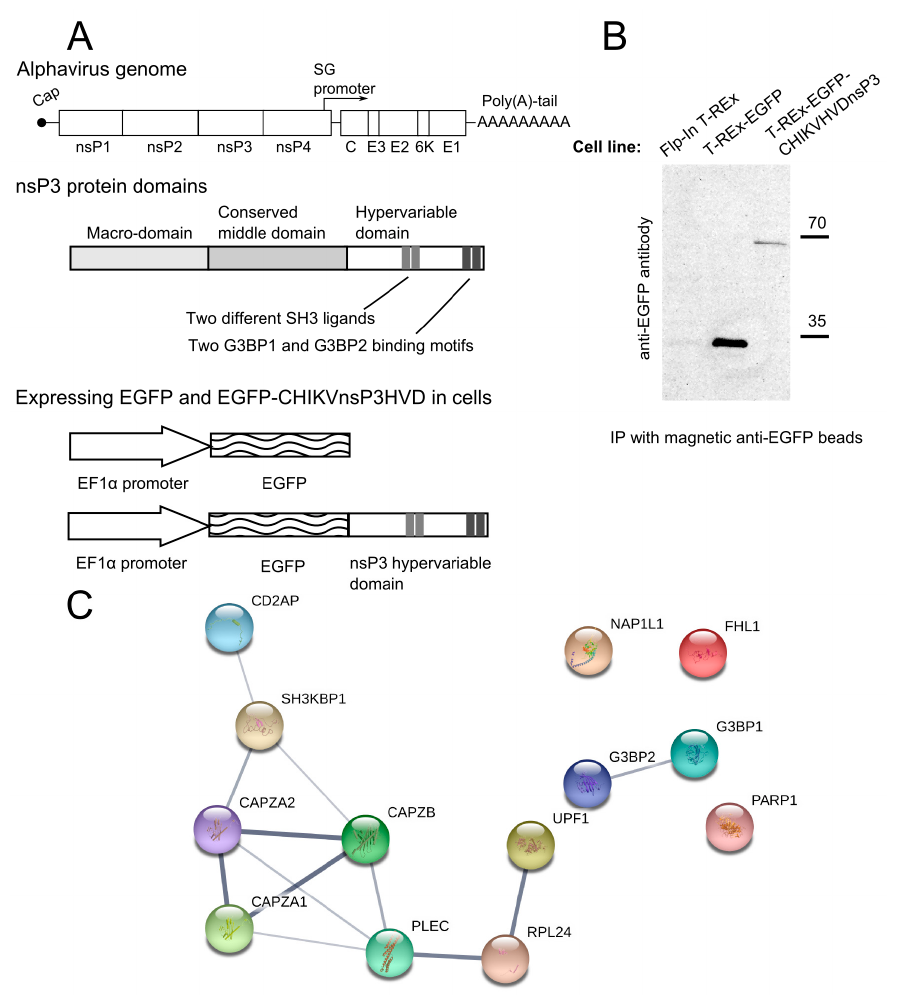
Figure 1. Proteins identified to associate with CHIKV nsP3 HVD. ( A ) The organization of CHIKV genome, the domains of nsP3 and schematics of constructs for expressing EGFP-CHIKVnsP3HVD and non-tagged EGFP in Flp-In T-REx cells; ( B ) Immunoblot analysis using anti-EGFP